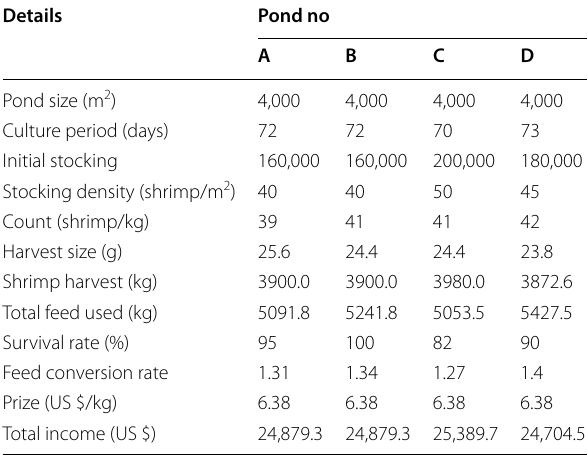
Table 1 The information of pond